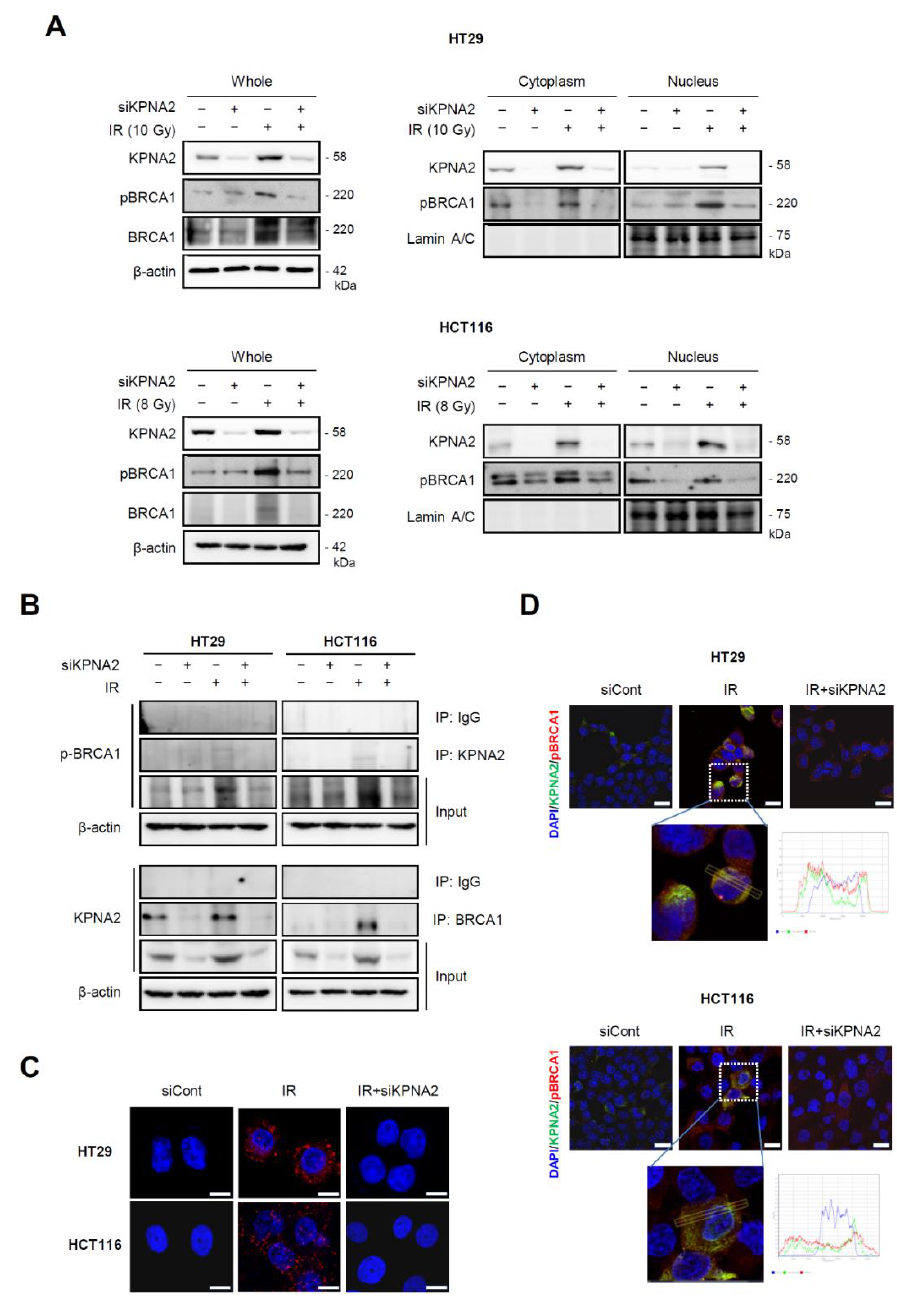
Figure 3. KPNA2 depletion interferes with the activation of radiation-induced BRCA1 proteins. HT29 and HCT116 cells were transfected with KPNA2 siRNA for 24 h and then treated with IR for 48 h. ( A ) Whole lysates and nuclear and cytoplasmic fractions of cells were analyzed by western blot for the indicated proteins. ( B ) Immunoblot analysis of KPNA2-BRCA1 interaction in HT29 and HCT116 cells pre-treated as indicated and immunoprecipitated for anti-KPNA2 or BRCA1. ( C ) Cells were fixed and incubated with mouse anti-KPNA2 antibody together with rabbit anti-BRCA1 antibody, followed by in situ proximity ligation assay (PLA). DNA was stained with 4 (cid:48) ,6-diamidino-2-phenylindole (DAPI). Representative confocal images are shown; each red dot represents a single interaction between KPNA2 and BRCA1 (original magnification × 400, scale bars 20 µ m). ( D ) Immunofluorescence staining showing the localization of KPNA2 (green) and pBRCA1 (red) in KPNA2 -depleted HT29 and HCT116 cells 48 h after IR (original magnification × 630, scale bars 20 µ m). The peak graph represents the localization of KPNA2 (green line) and pBRCA1 (red line) in the nucleus (blue